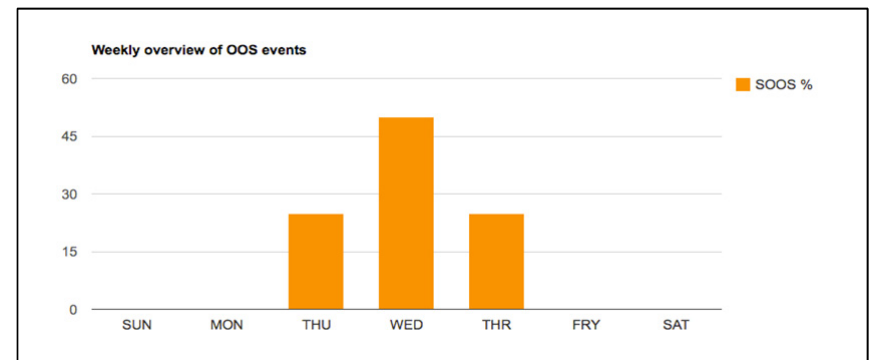
Figure 10. Rate of SOOS related to a week.